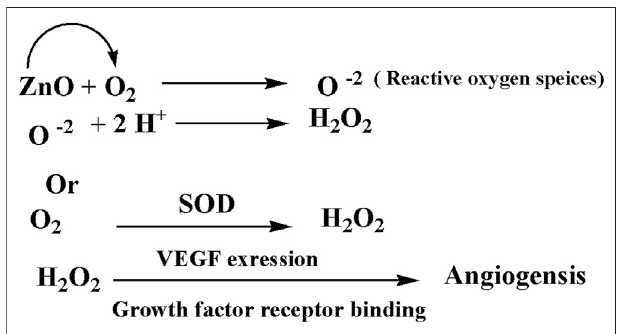
FIGURE 15 | A plausible mechanism of